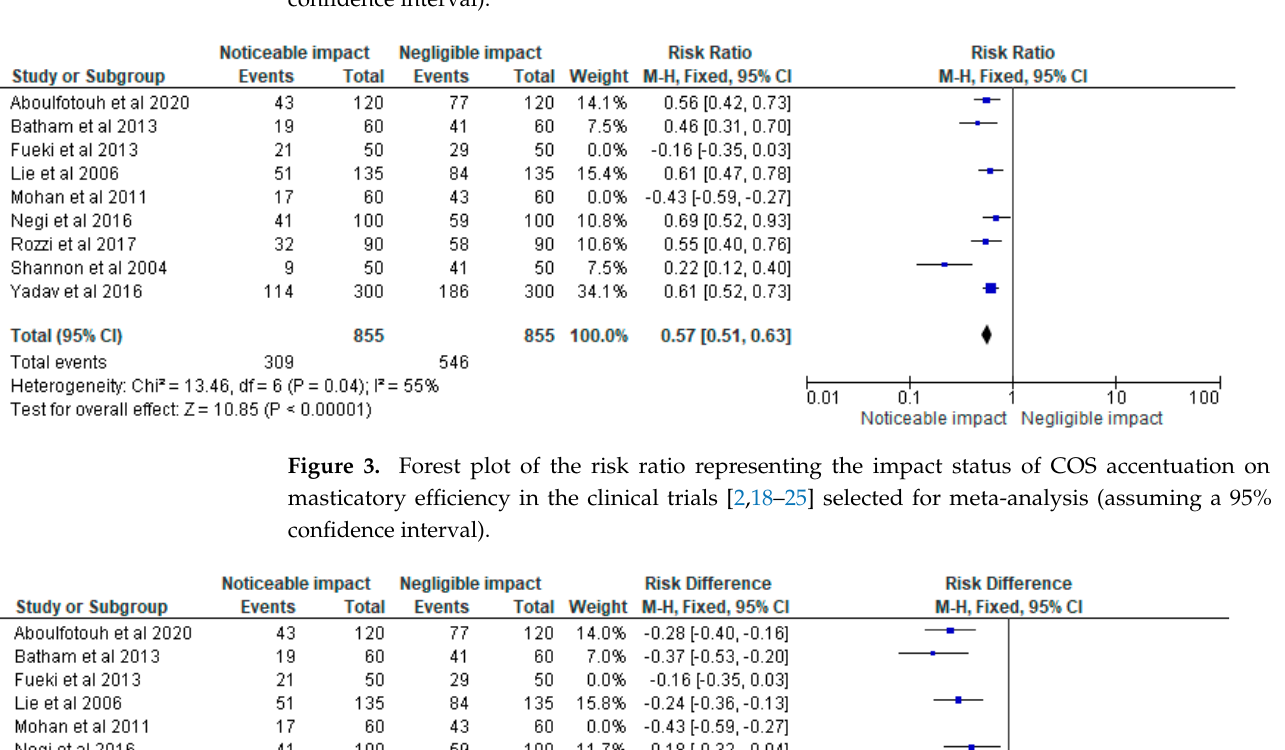
Figure 2. Forest plot of the odds ratio representing the impact status of COS accentuation on masticatory efficiency in the clinical trials [2,18–25] selected for our meta-analysis (assuming a 95% confidence interval).